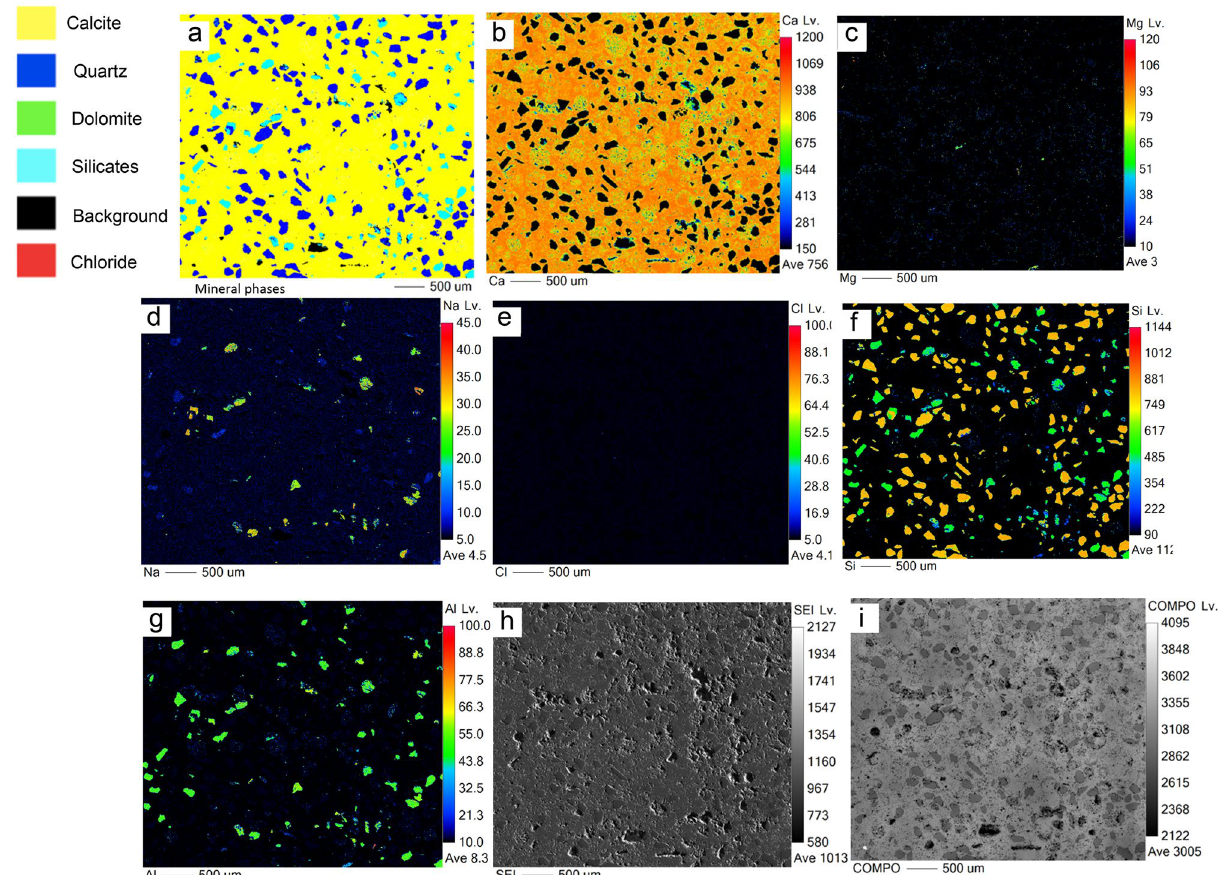
Figure 7. EPMA results of MV1 showing: ( a ) mineralogic maps, elemental maps of ( b ) Ca, ( c ) Mg, ( d ) Na, ( e ) Cl, ( f ) Si, and ( g ) Al, ( h ) secondary electron image, and ( i ) backscattered image. Dolomite and traces of salt are absent with textural homogenous